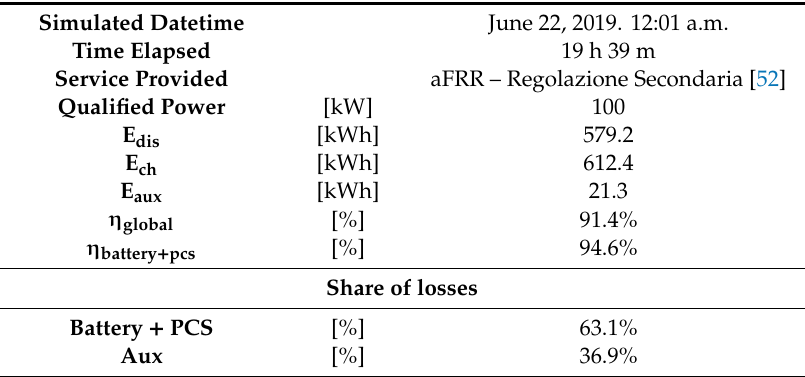
Table 13. Summary of the results of aFRR provision.